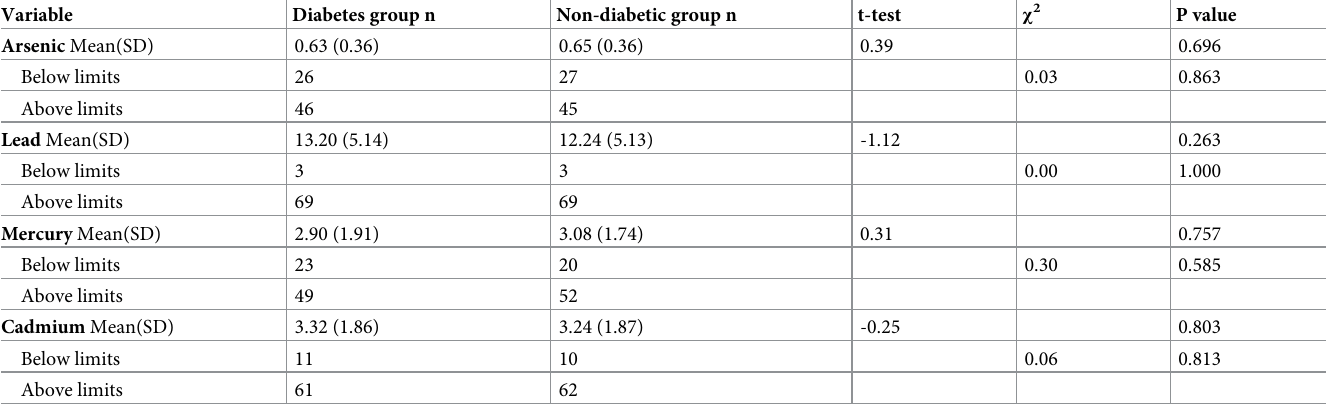
Table 4. Comparison of toxic heavy metal concentrations in the breast milk of diabetic and non-diabetic groups N =